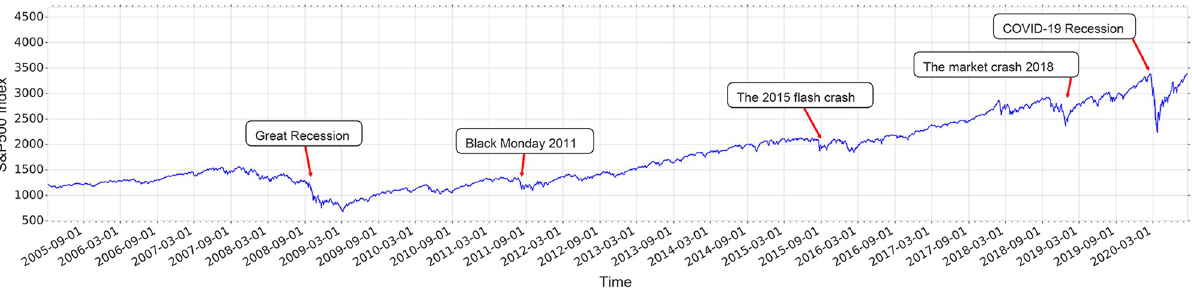
Fig 1. Crisis index. Time series of S & P 500 index with highlighted